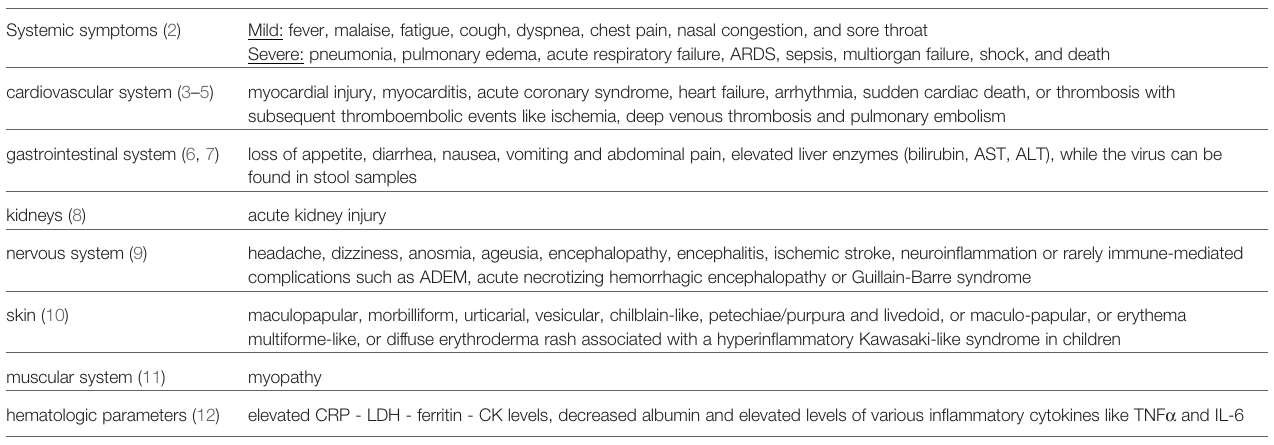
TABLE 1 | COVID-19 is a systemic disease affecting many different